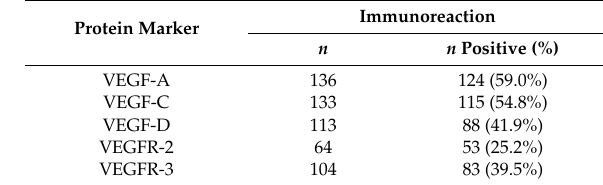
Table 2. Frequencies of positive VEGF family immunoreactions in the CRC LNM.